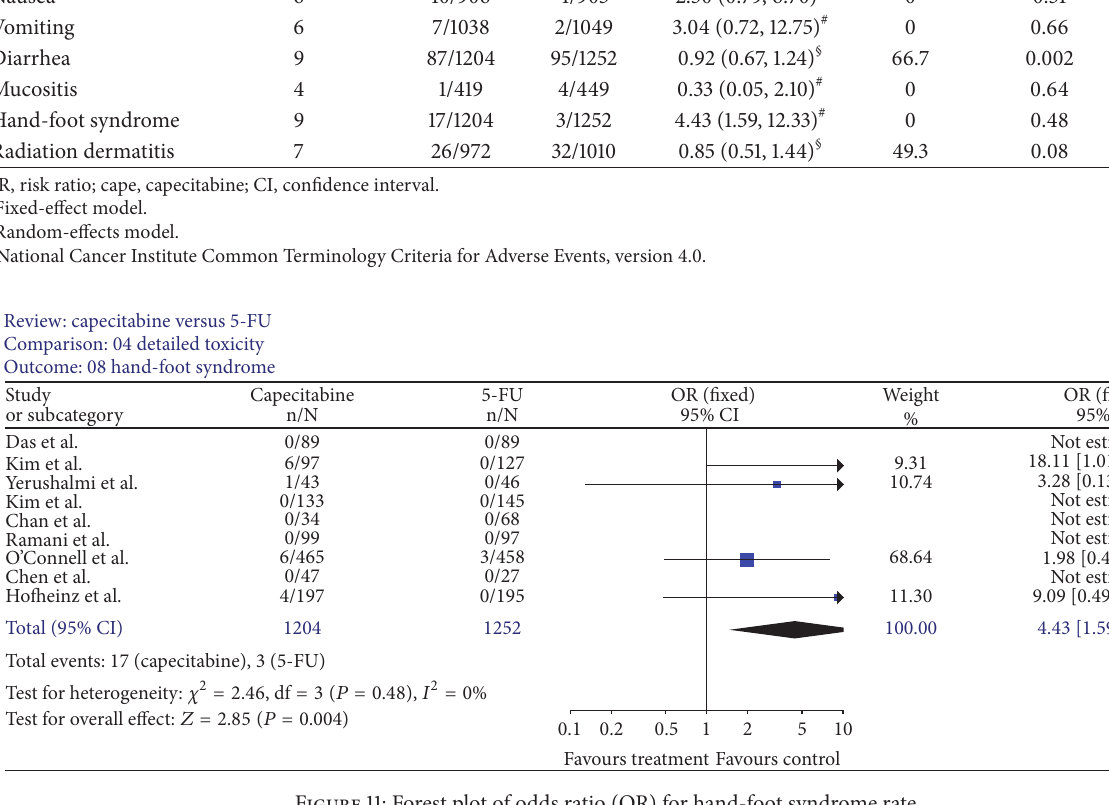
Figure 11: Forest plot of odds ratio (OR) for hand-foot syndrome rate.